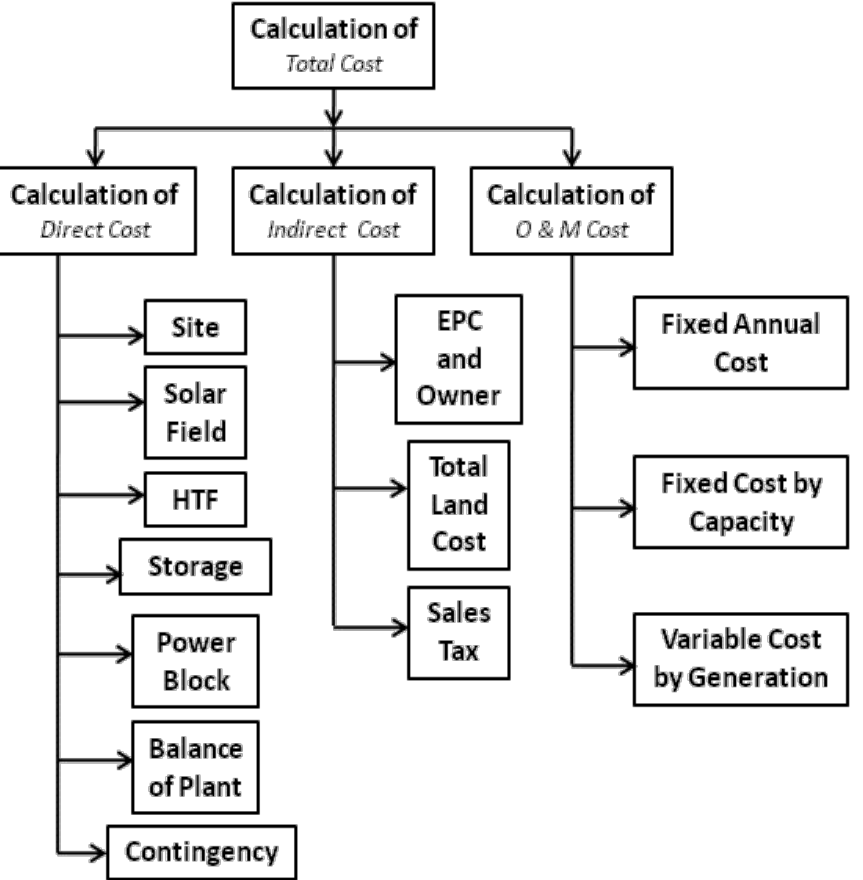
Fig. 1. Illustration diagram for cost analysis via SAM simulation